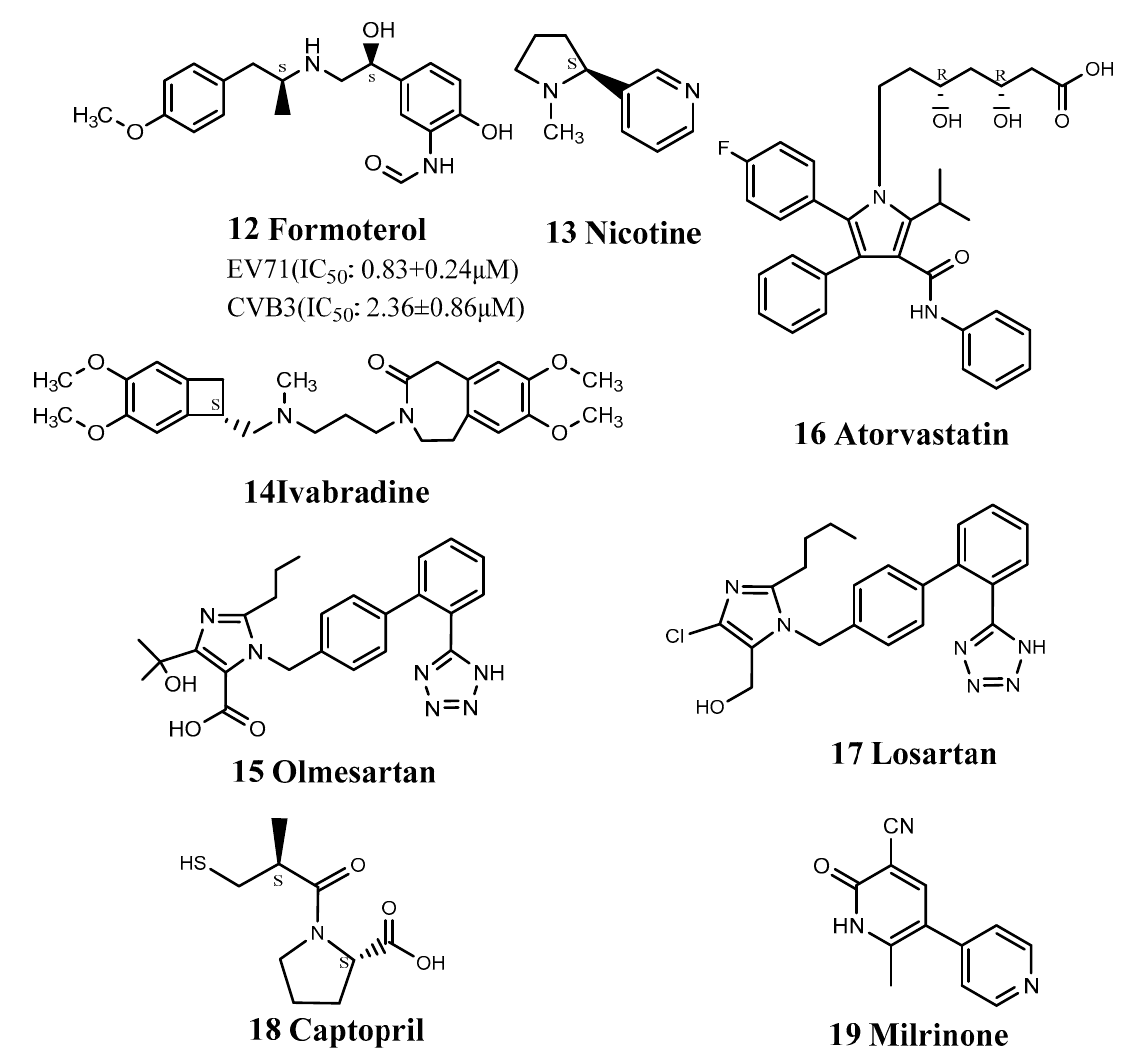
Figure 4. Structures of cardiovascular